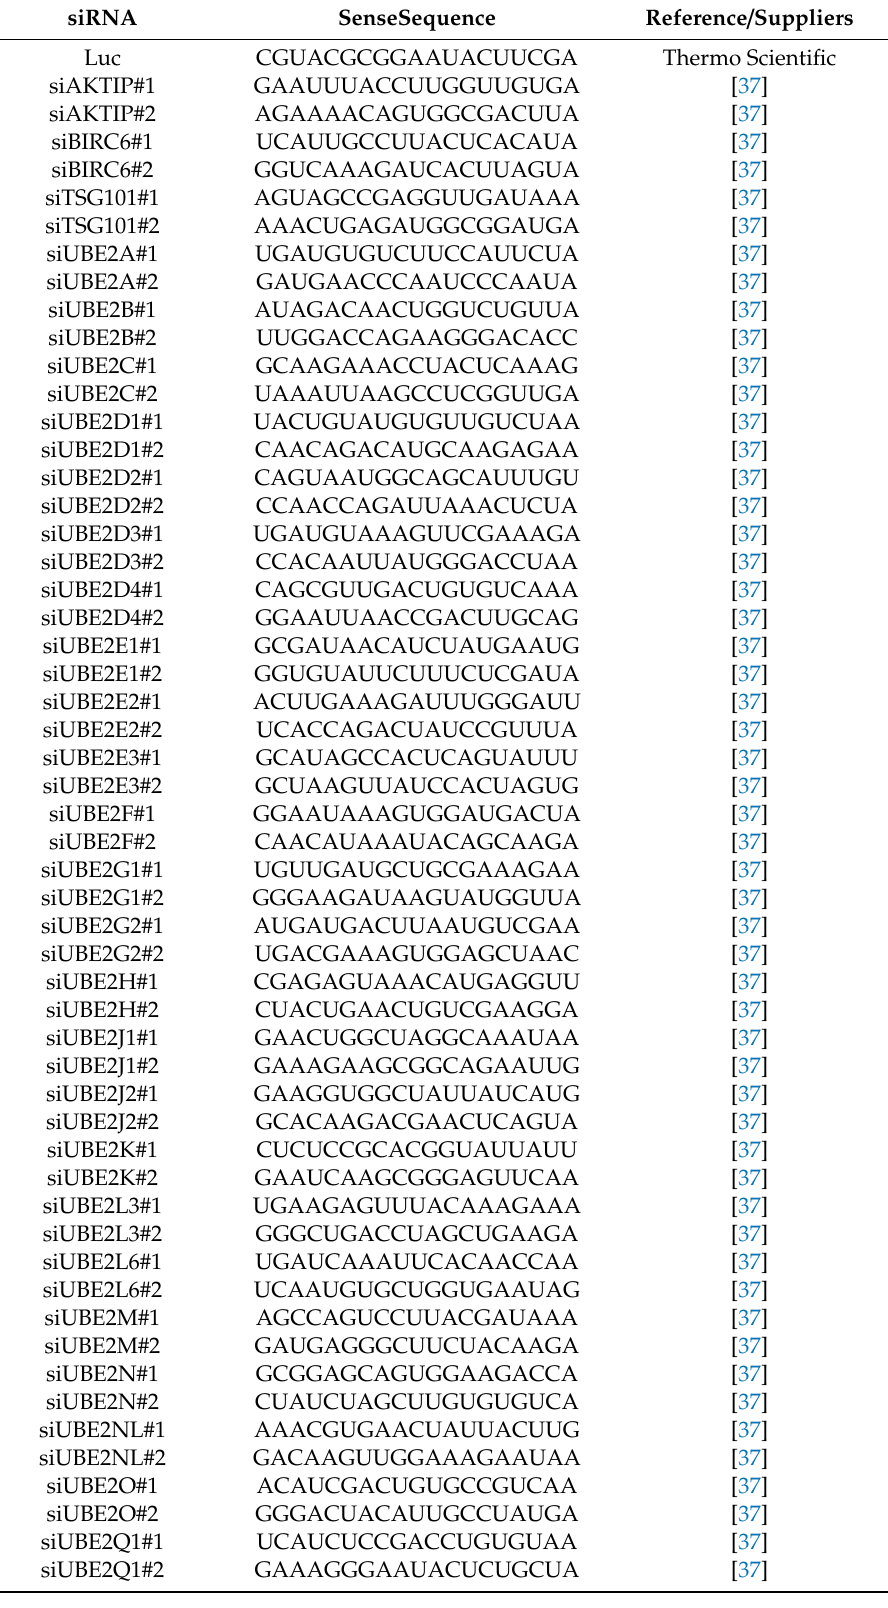
Table 5. List of